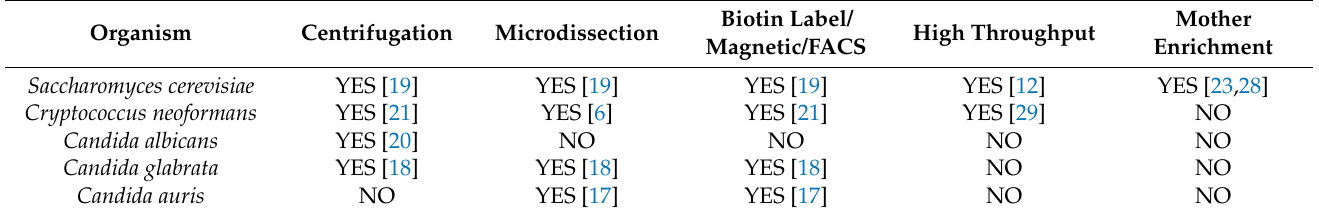
Table 1. Methods to analyze replicative life span (RLS) used in different pathogenic yeasts.